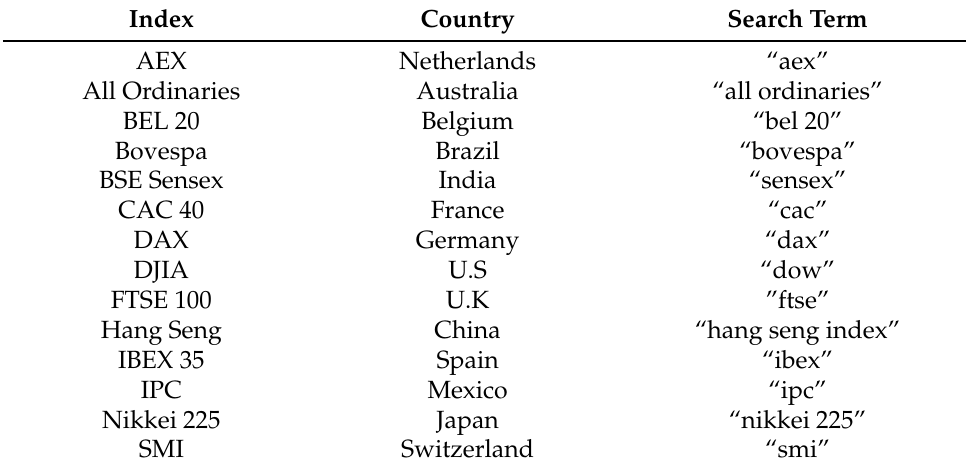
Table 1. List of stock market indices and search terms.